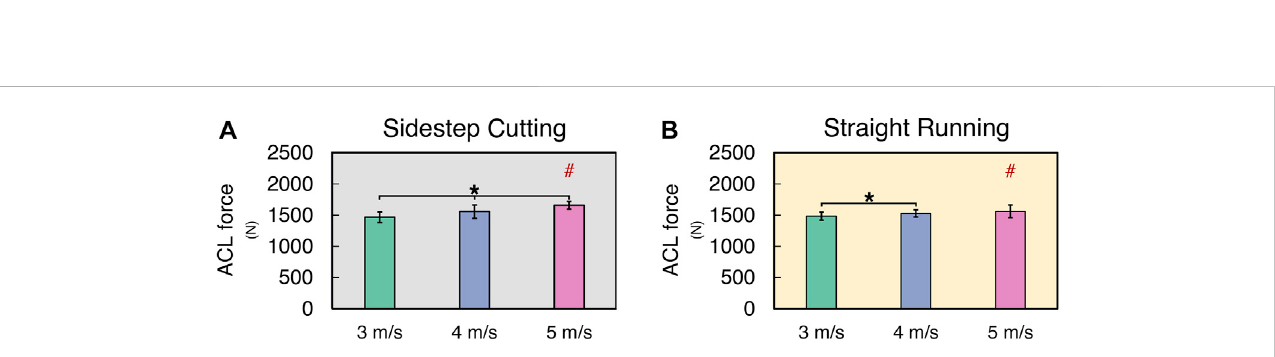
FIGURE 3 The mean and standard deviation of ACL force during (A) sidestep cutting ( Gray ) and (B) straight running ( Yellow ). Note: Units expressed in newton. Signi fi cant differences between VELOCITIES denoted byasterisks(*) ( p < 0.05). Signi fi cant differences betweenrunning TYPES for each condition denotedby hash (#) ( p < 0.05).